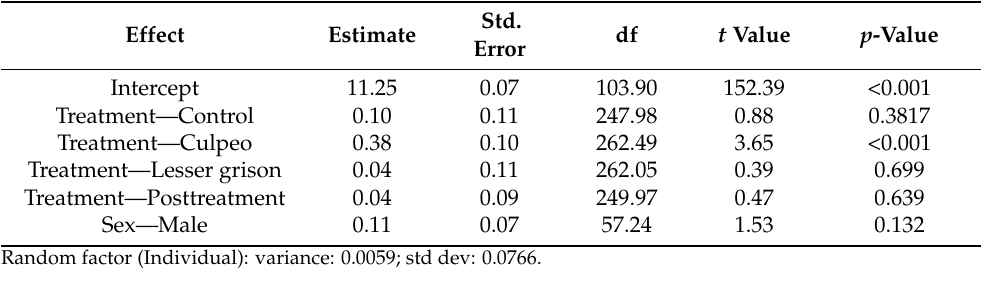
Table 2. Results of the GLMM, analysing the effect of experimental and environmental factors on O. longicaudatus faecal corticosterone metabolite levels.